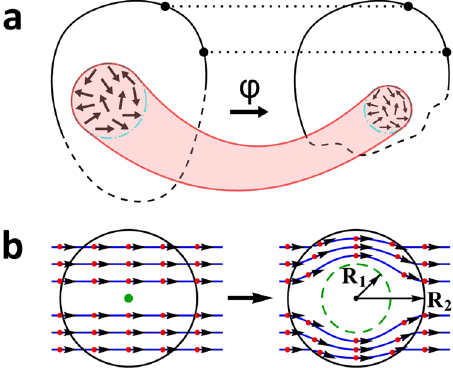
Figure 1. Transformation diffeomorphisms. ( a ) A region of the original space with boundary is mapped by ϕ , a diffeomorphism in the interior, to a subregion in the virtual space. The pushed forward vectors from the tangent space are also schematically denoted. The identity map on the partial boundary (full black line) takes boundary points from the original region and maps them to the same respective boundary points in the subregion. ( b ) Diffeomorphism of a circular cloak (equation (6)). The transformation takes a point (green) from the original space and moves it radially outward in the virtual space (green dashed curve). In the annular region R 1 < r < R 2 , the originally straight lines curve around the r = R 1 circle making the interior region r < R 1